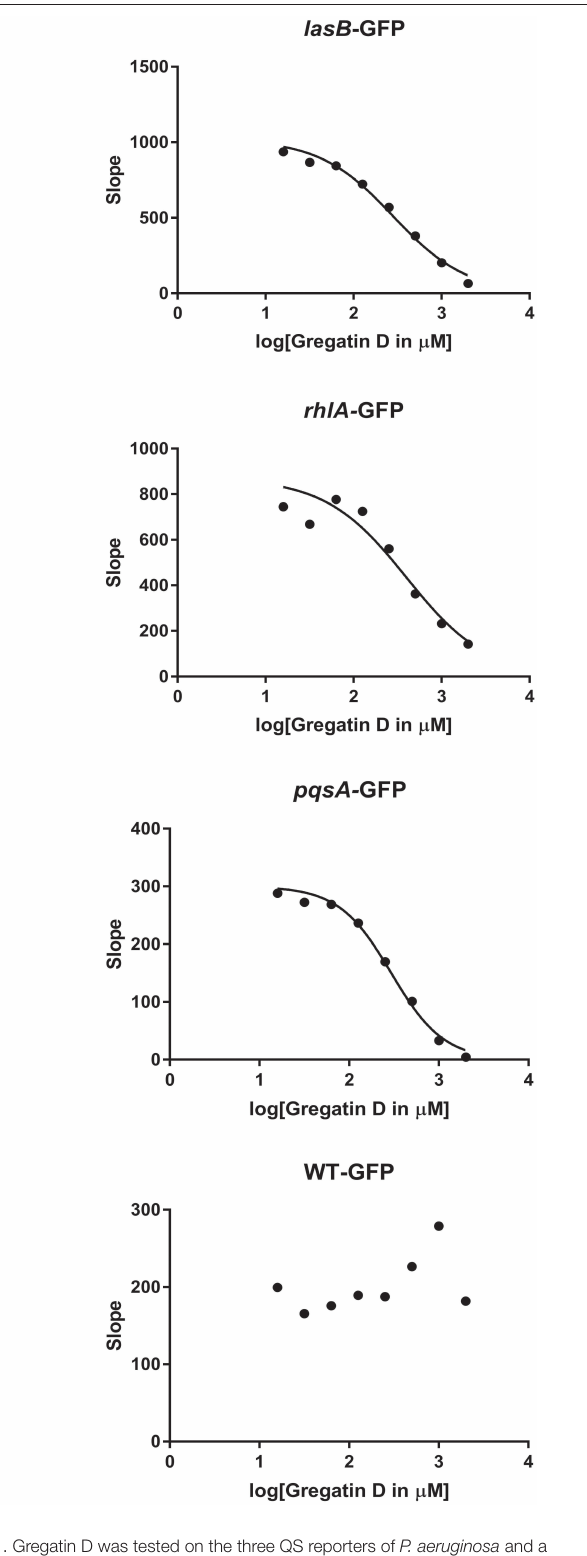
Frontiers in Microbiology | www.frontiersin.org 10 July 2022 | Volume 13 | Article